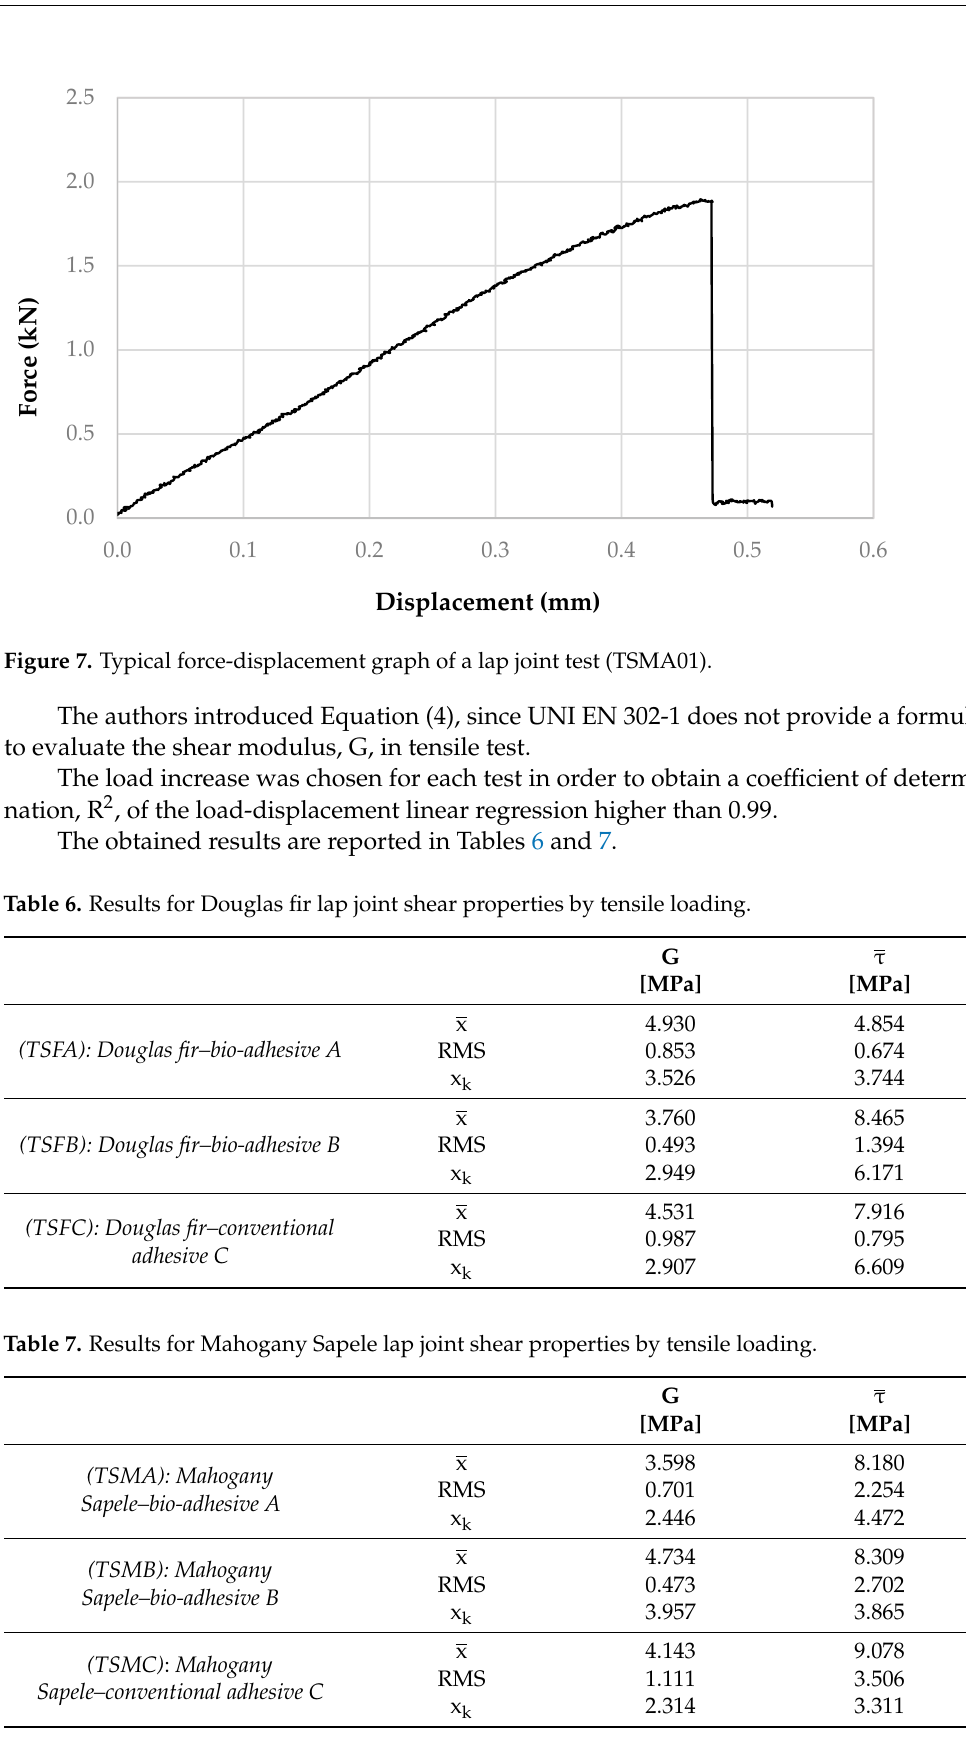
Figure 6. Lap joint test. ( a ) during the test, ( b ) after rupture. For each specimen, the test results were represented by a force-displacement graph (Figure 7).